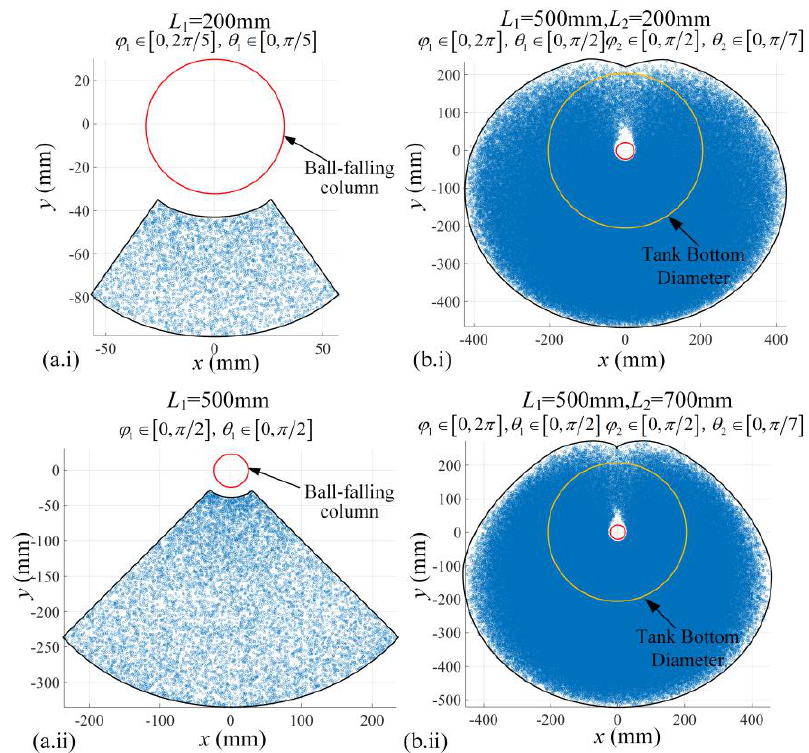
Figure 8. Reachable workspace of the continuum robot: ( a . i , a . ii ) workspace of the distal segment ( L 1 = 200 mm and 500 mm); ( b . i , b . ii ) workspace of the dual-segment continuum robot ( L 1 = 500 mm, L 2 = 200 mm and 700